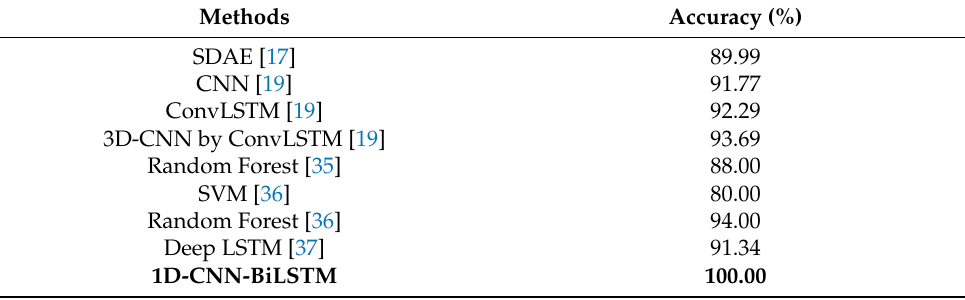
Table 10. Comparative results on the single accelerometer dataset.